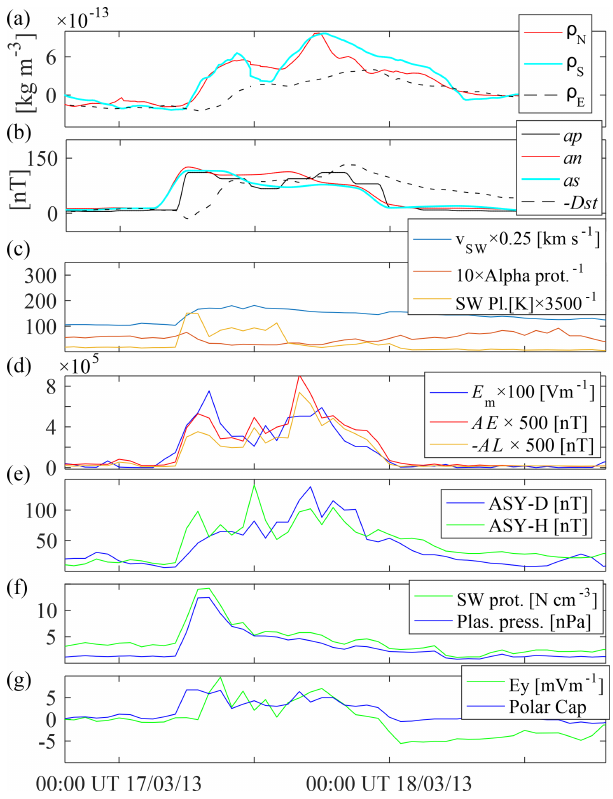
Figure 1. In (a) , the northern, southern, and equatorial profiles of residual density disturbances ( ρ r ) are shown for the moderate (G2) geomagnetic storm on 18 March 2013 (free from solar cycle, LST, and annual variations, and normalized to an altitude of 475km). Space weather and geomagnetic indices are plotted below from (b) to (g) . Magnitudes have been rescaled as indicated in each legend.